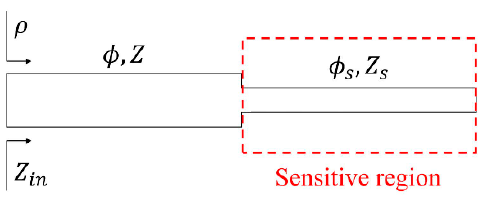
Figure 1. Topology/schematic of the step-impedance open-ended line reflective-mode phase-variation sensors. A single step-impedance discontinuity is considered, but further discontinuities are possible.